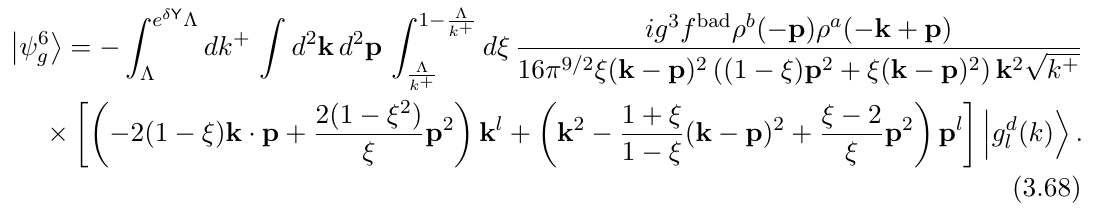
Figure 8 . One gluon production diagrams involving the triple gluon vertex. (a) - Just as in the previous calculations, the momentum conservation imposes q = k and r = k (cid:0) p . This is how this process is illustrated in (cid:12)gure 8b with our usual de(cid:12)nition